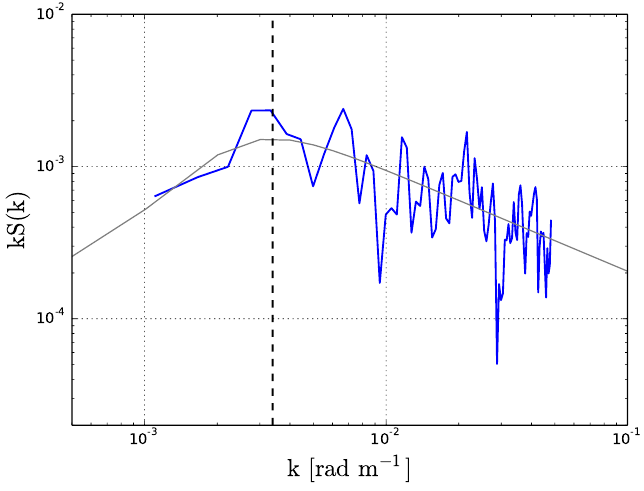
Figure 1. An example of a vertical velocity power spectral den- sity ( S ) as a function of the wave number k (blue line) taken from roughly the middle of the well-mixed layer on 25 February at 04:00UTC. The thin grey line represents the fit from Eq. (3). The black dashed line shows the wave number corresponding to λ 0 in this particular example. The inertial subrange is found for wave numbers above this